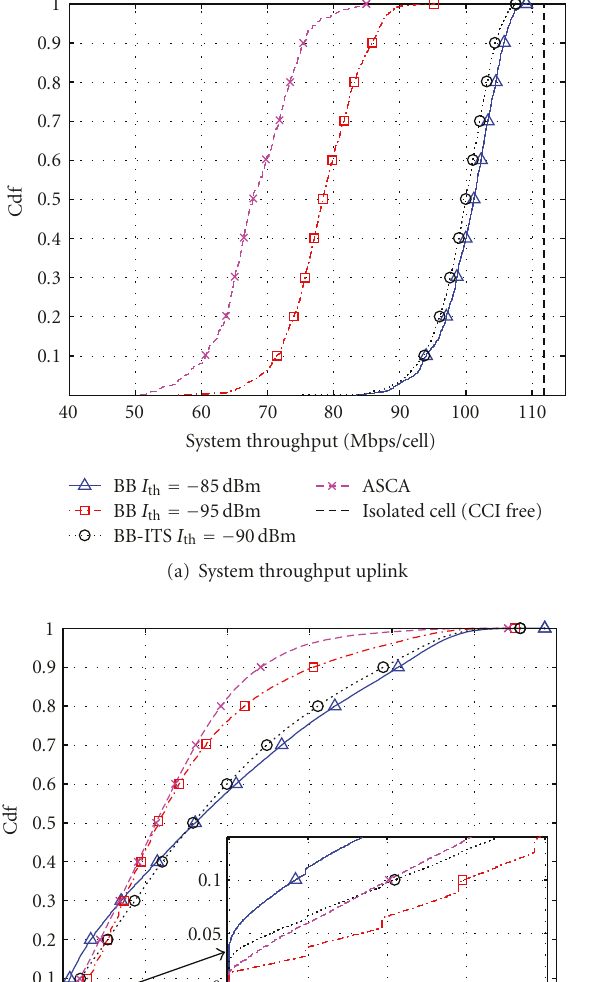
concern, I th = − 95 dBm in the uplink and I th = − 90